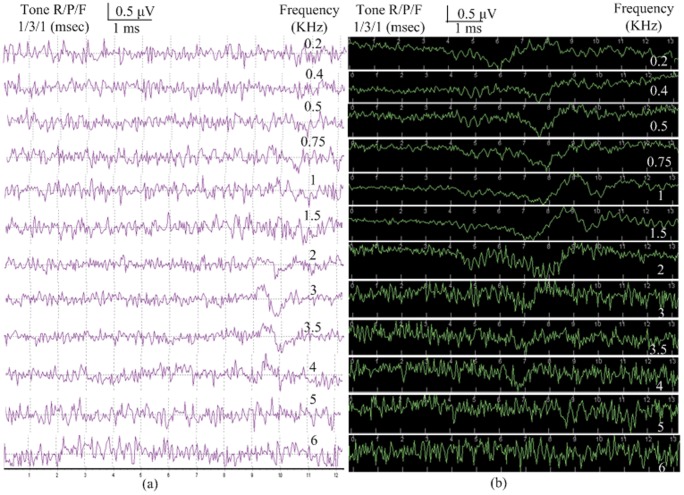
ABR replicates elicited in response to frequency-specific tone pips at 70 dB SPL from the same frog showing valley-peak waveforms in the reproductive season (a) and non-reproductive season (b).Rise, plateau and fall (R/P/F) for each frequency are specified on the left-hand side of the figure.